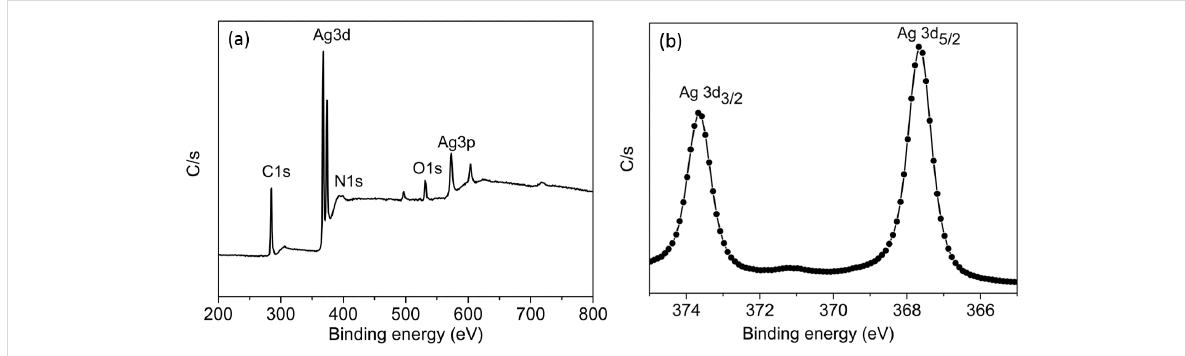
Figure 2: (a) XPS survey and (b) high-resolution Ag 3d spectra of casein peptide-capped silver nanoparticles.